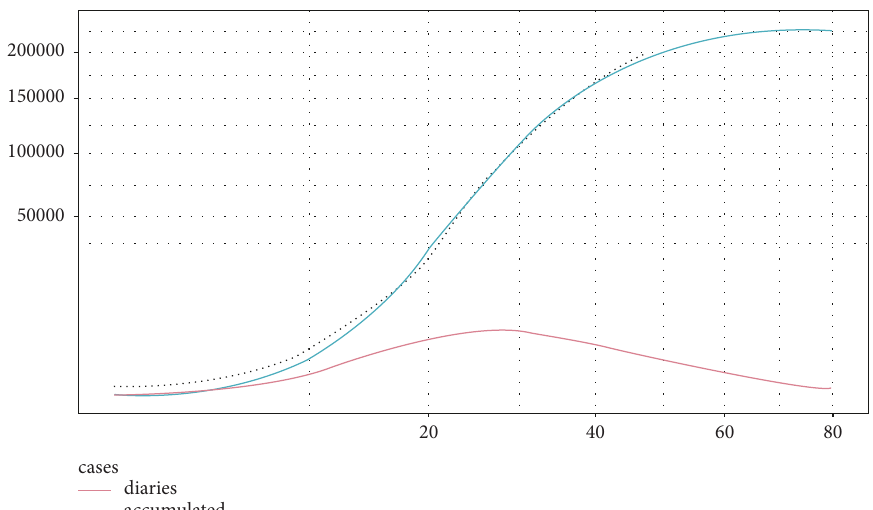
Figure 4: Estimated cases in Spain according to the model on April 19 (day 47 of the series of registered data) by S ´ anchez-Villegas and Daponte